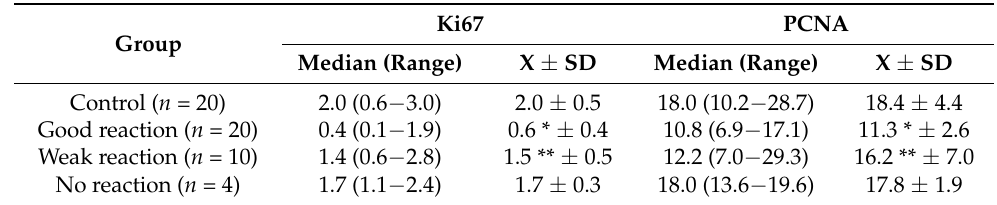
Figure 3. Representative light micrographs of proliferating cell nuclear antigen (PCNA) and Ki67 immunoexpression in myoma cells (brown-stained nuclei) in the control group ( A , E ); in the group with good reaction to UPA treatment ( B , F ), in the group with weak reaction to UPA (ulipristal acetate) (treatment ( C , G ) and in the group with no reaction to UPA treatment ( D , H ). A – D : PCNA immunoexpression; E – H : Ki67 immunoexpression. Scale bar—100 µ m. C—control group; GR—good reaction to treatment; WR—weak reaction to treatment; NR—no reaction to treatment. Table 4. The percent of Ki67-positive and PCNA-positive cells in fibroids in the control group and the study groups after three months of treatment with ulipristal